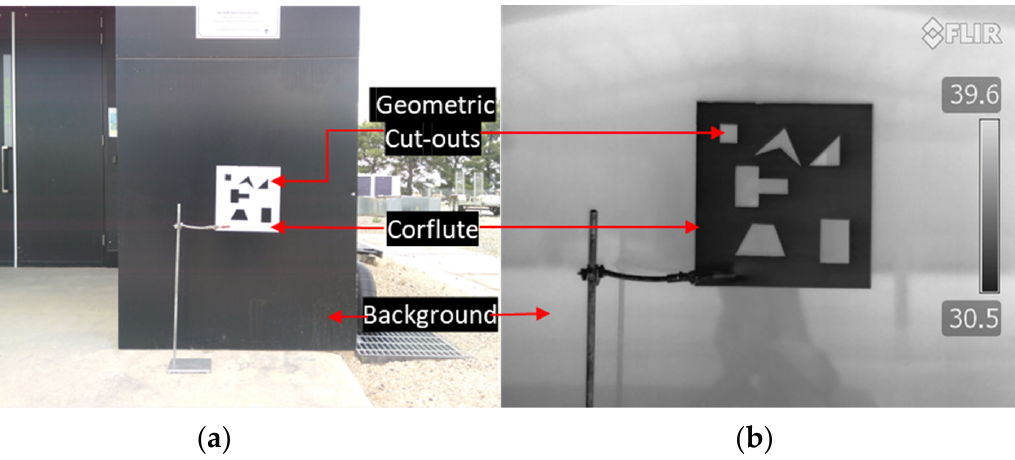
Figure 5. Setup for coarse image registration: ( a ) FoV of RGB; ( b ) FoV of thermal image. A white corflute with different geometric cut-outs was placed in front of a black background with a higher surface temperature than the corflute sheet. The cut-outs are visible in optical (RGB), multispectral, and thermal image